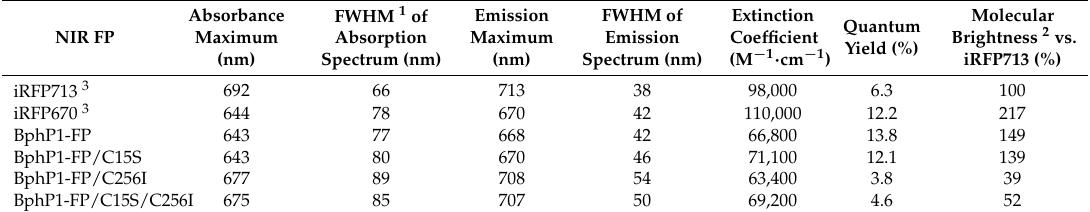
Table 1. Spectral and biochemical properties of fluorescent protein BphP1-FP, engineered from bacterial phytochrome RpBphP1, and its variants with different location of Cys residues.